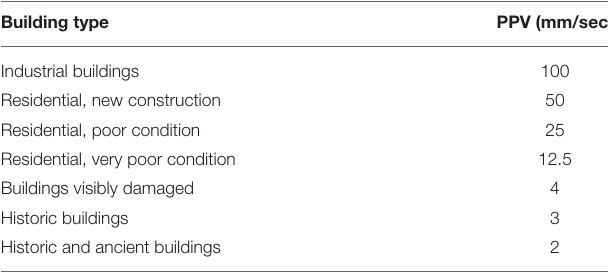
TABLE 1 | Frequency of vibration induced by different vehicles (Barneich, 1985). Type of vehicle